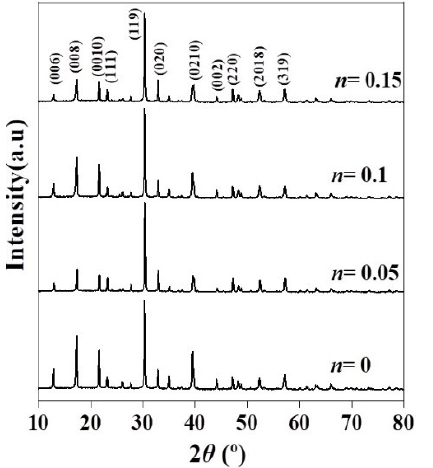
Fig 1. The diffractogram of SrBi 4 Ti 4- n V n O 15 ( n = 0, 0.05, 0.1, and 0.15) Table 1. Crystallite size of SrBi 4 Ti 4- n V n O 15 ( n = 0, 0.05, 0.1, and 0.15)